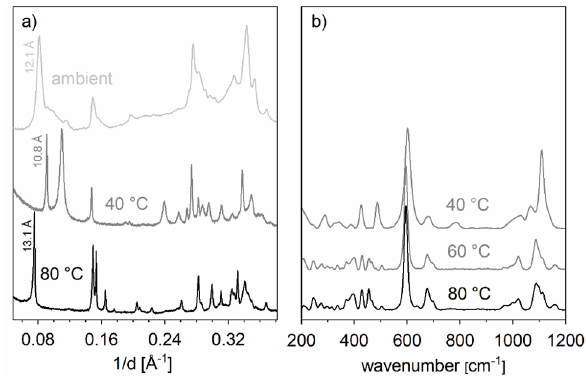
Figure 12. Effect of temperature on types of formed ASR products: (a) XRD patterns for the ASR products formed at 80 °C (13.1 Å), 40 °C (10.8 Å) and ambient condition (12.1 Å); (b) Raman spectra for the ASR products formed at 80 °C, 60 °C and 40 °C. Adapted from